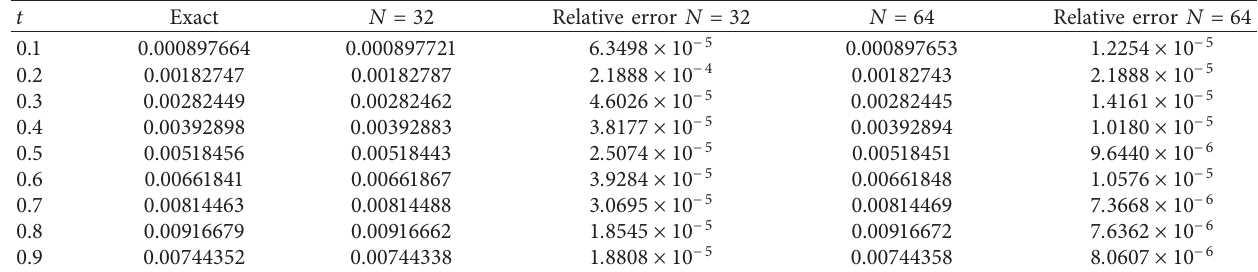
Figure 4: The exact solution (a) and the approximate solution (b) by the sinc method for 0 < t < 0 . 5 and − 5 ≤ x ≤ 5 for Example 1. Table 3: Some results of the sinc method for two different values of N and comparison of them with the exact solution when a � 1 . 1 and μ � 0 . 001 for Example